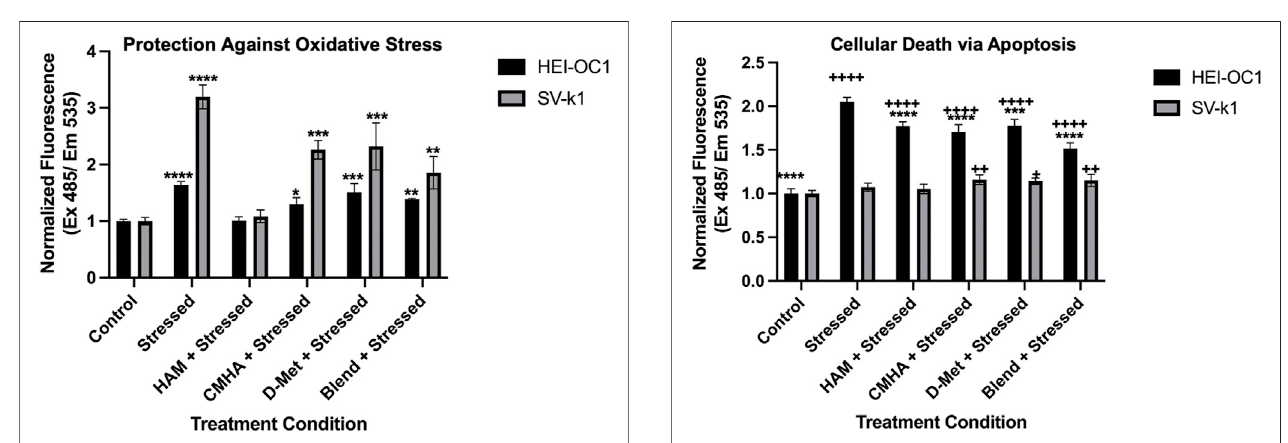
FIGURE 3 | Oxidative stress protective effects of the conjugate in cochlear cell lines. Data presented are mean ± SD. One-way ANOVA with Tukey ’ s multiple comparisons run for each cell type individually. HEI-OC1 ANOVA results compared to unstressed untreated control: stressed p < 0.0001, HAM p > 0.9999, CMHA p = 0.0118, D-Met p = 0.0001, and blend p = 0.0016. **** p < 0.0001, *** p = 0.0001, ** p = 0.01, and * p = 0.05. SV-k1 ANOVA compared to control: Stressed p < 0.0001, HAM p = 0.9974, CMHA p = 0.0004, D-Met p = 0.0002, and blend p = 0.0091. **** p < 0.0001, *** p = 0.0001, ** p = 0.01, and * p = 0.05.